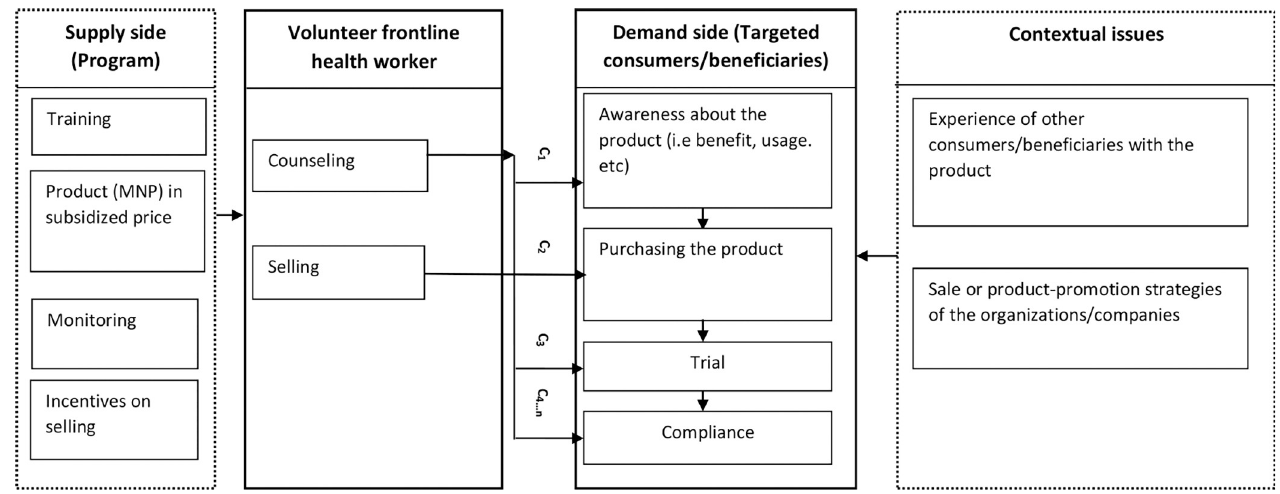
Fig 1. Conceptualizing market-based approach to promoting a product (MNP) with the involvement of volunteer frontline health worker.